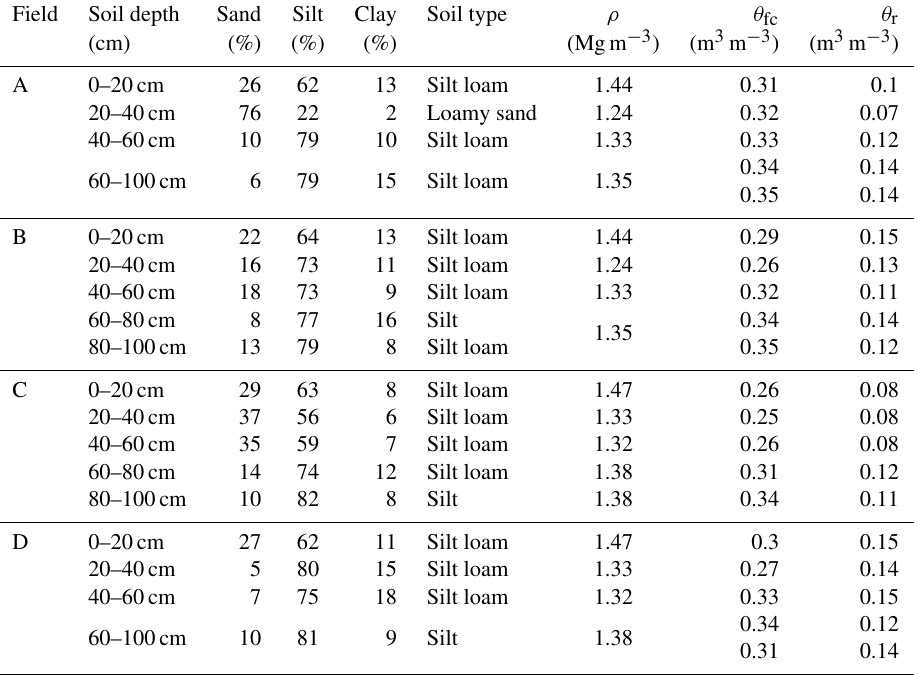
Table 2. Soil texture and bulk density of the experimental fields in Shahaoqu.